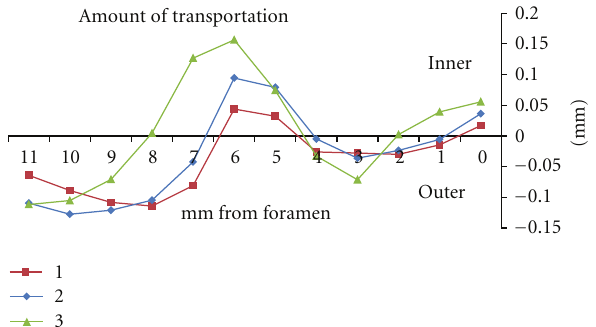
Figure 3: S-shaped simulated canals: pictures superimposed.